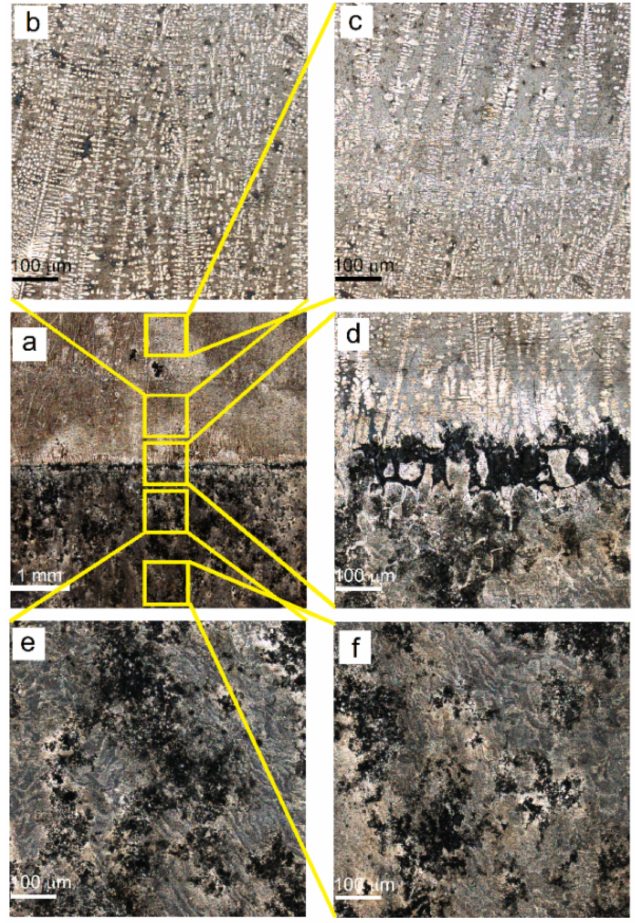
Figure 17. Optical confocal images of corroded surfaces of the samples. Corroded surface macrograph ( a ), as-deposited AA4047 zones ( b , c ), transition zone ( d ), heat-affected AA7075 ( e ), as-received AA7075-T42 ( f